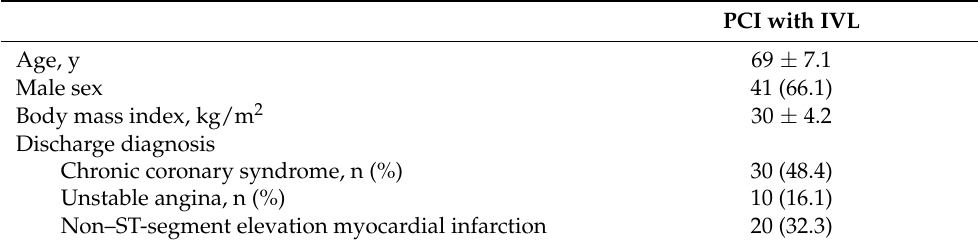
Table 1. Patient characteristics, risk factors, and clinical